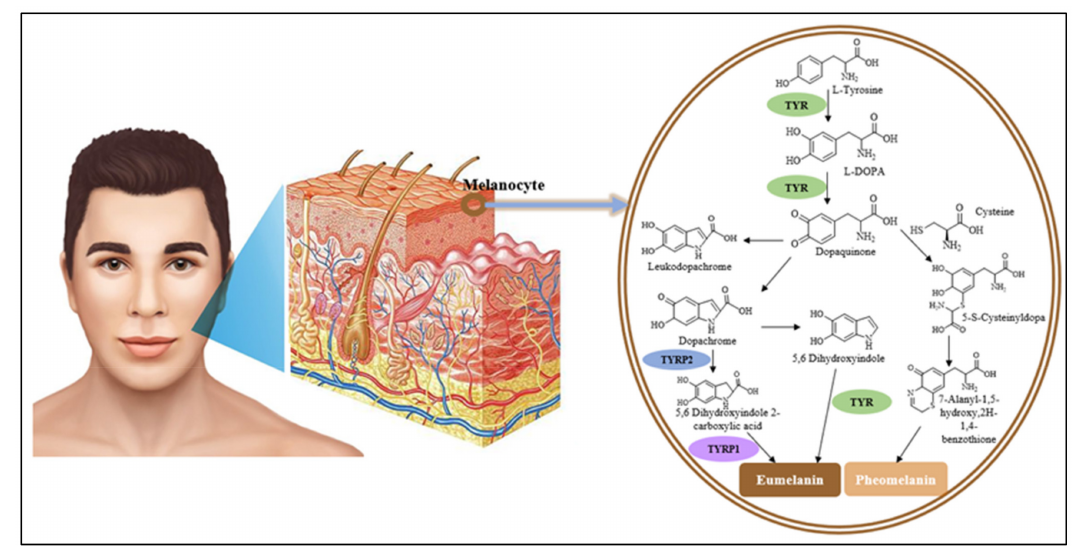
Figure 1. The pathway of melanin biosynthesis catalyzed by tyrosinase. TYR, tyrosinase; TYRP2, tyrosinase-related protein-2; TYRP1, tyrosinase-related